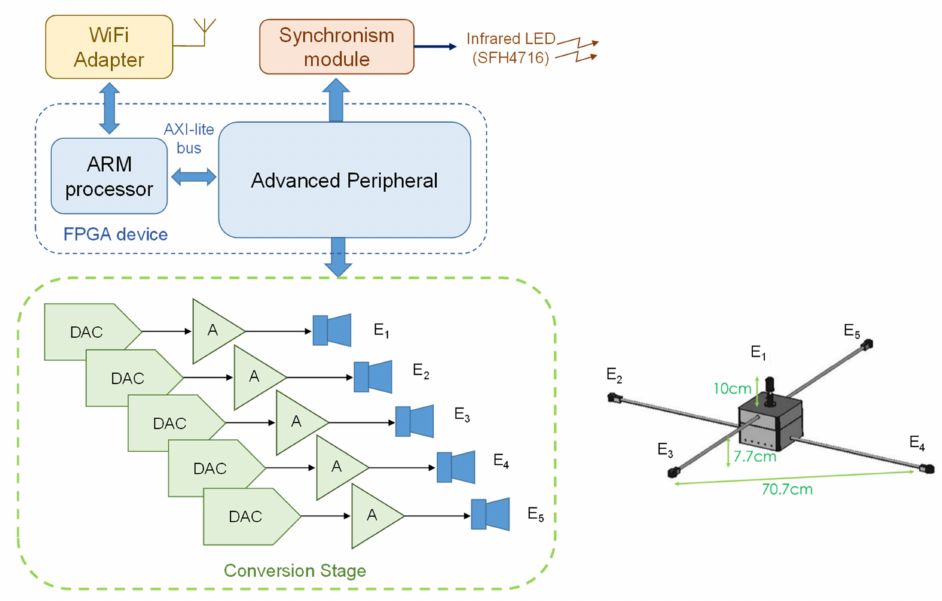
Figure 16. General block diagram of the beacon unit involved in the CODEUS online demonstrator [65].